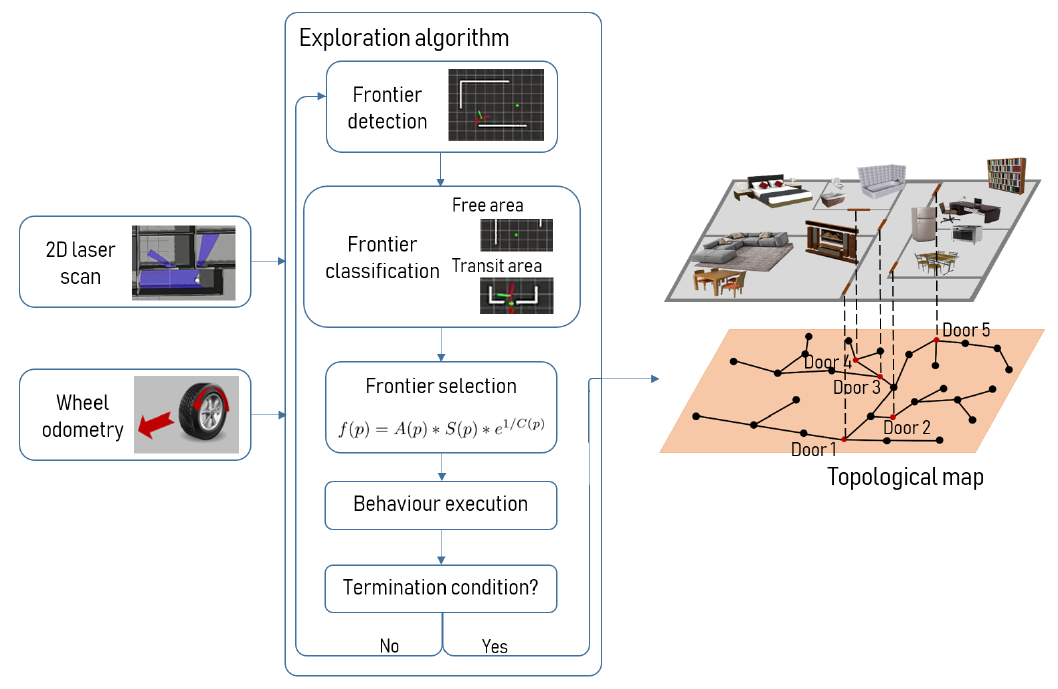
Figure 2. Processes involved in the exploration algorithm. The inputs of the system are the scans from a 2D laser and the odometry of the robot. The output of the system is the topological map of the environment.